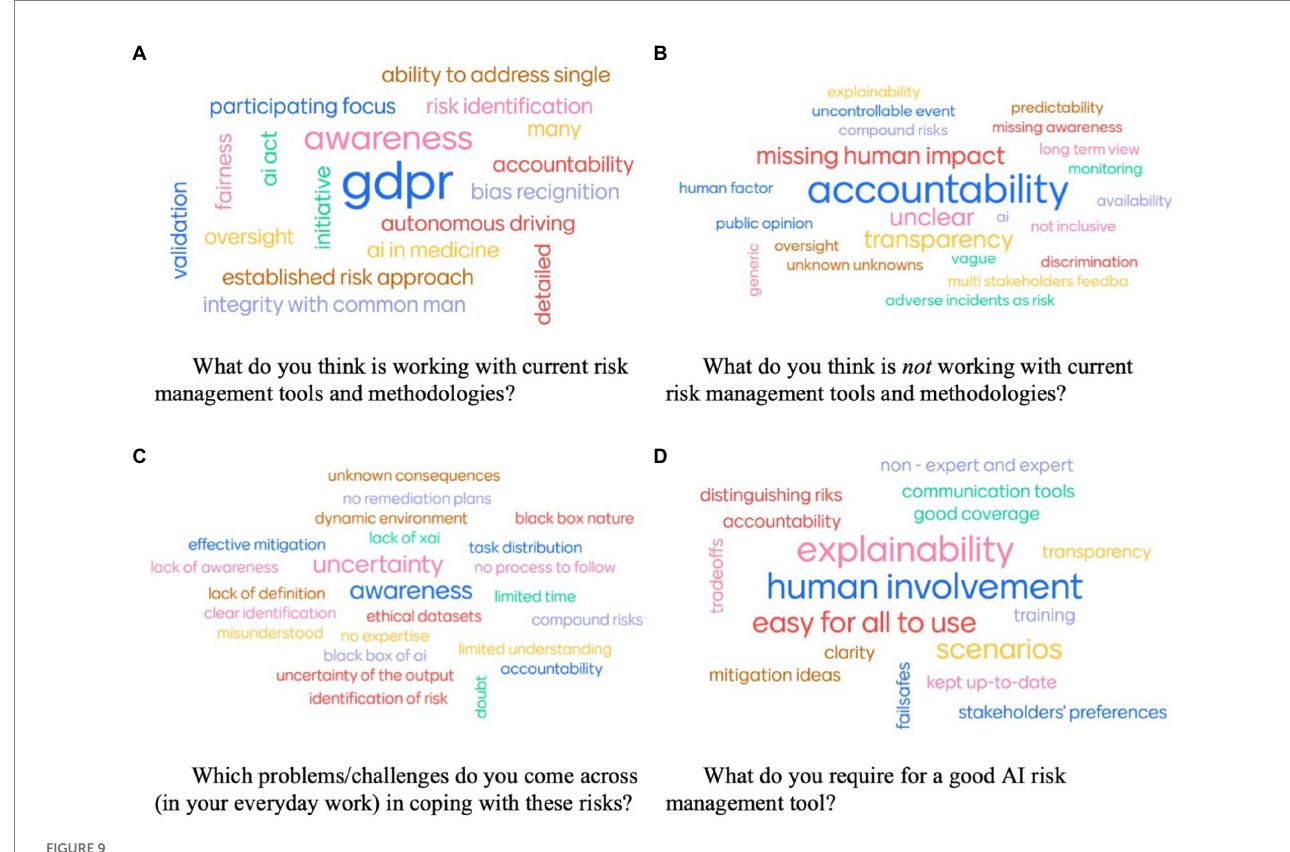
FIGURE 9 Word clouds of answers from participants to the four qualitative questions. (A) What do you think is working with current risk management tools and methodologies? (B) What do you think is not working with current risk management tools and methodologies? (C) Which problems/challenges do you come across (in your everyday work) in coping with these risks? (D) What do you require for a good AI risk management